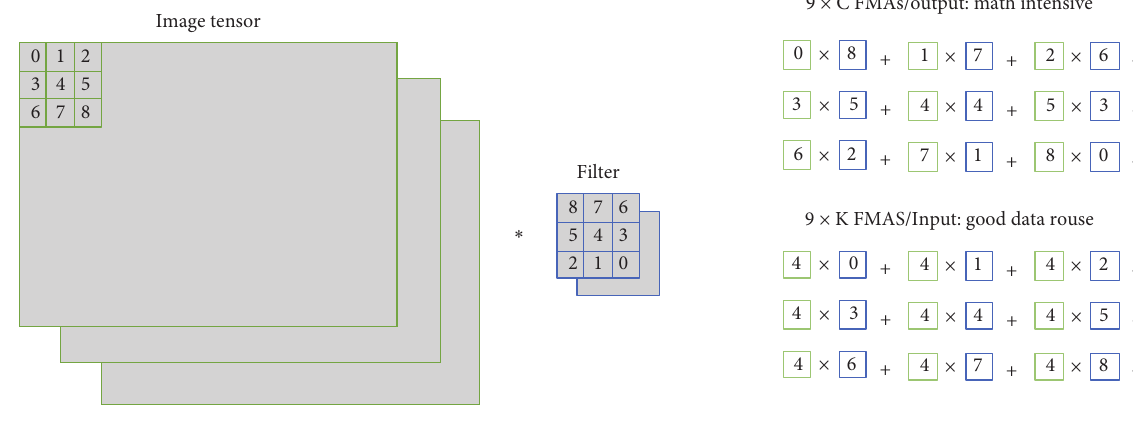
Figure 3: Process of convolution in